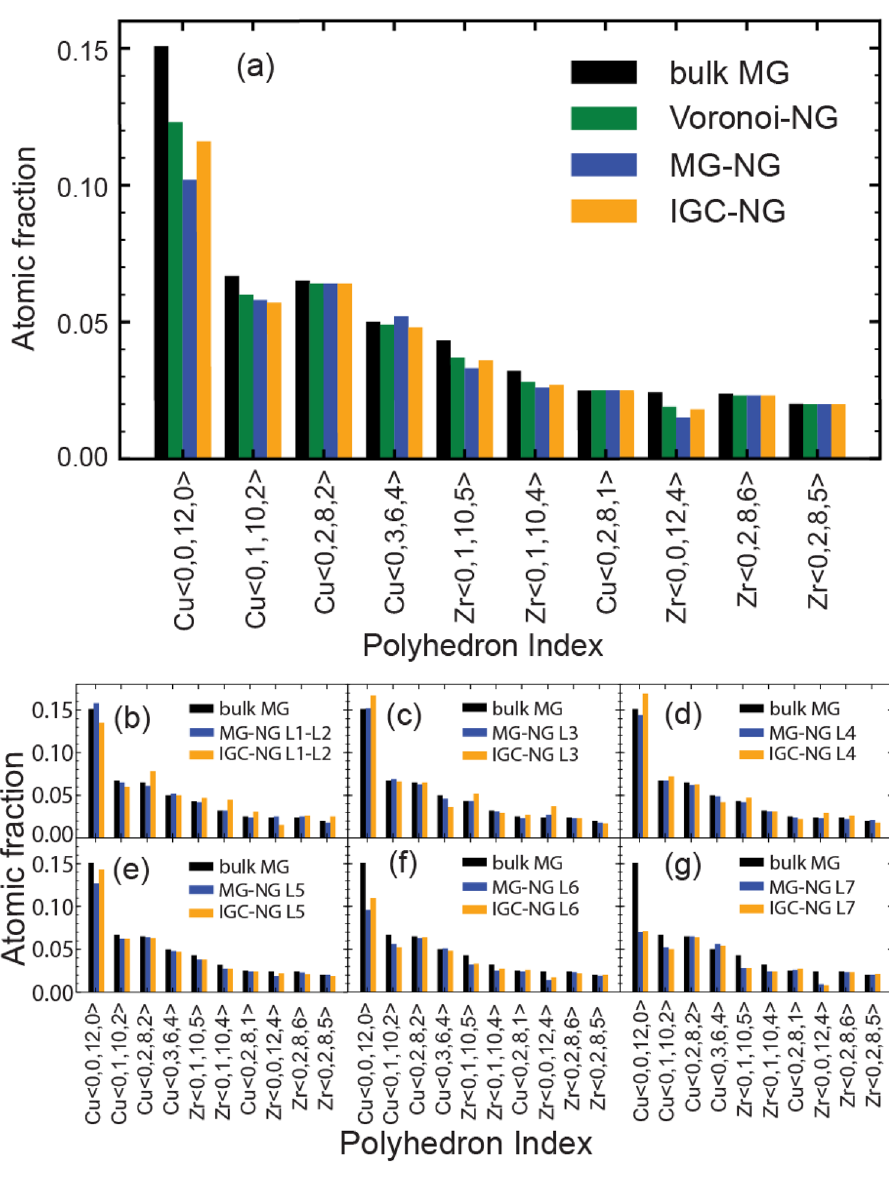
Figure 7. Statistics of the most prominent Voronoi polyhedrons in the Voronoi-NG, MG-NG, IGC-NG, and bulk MG models. ( a ) Statistics of the most prominent Voronoi polyhedrons in different NG and MG models ( b )–( g ) Corresponding statistics of the MG-NG and IGC-NG models split in seven layers from the core of the particles to their